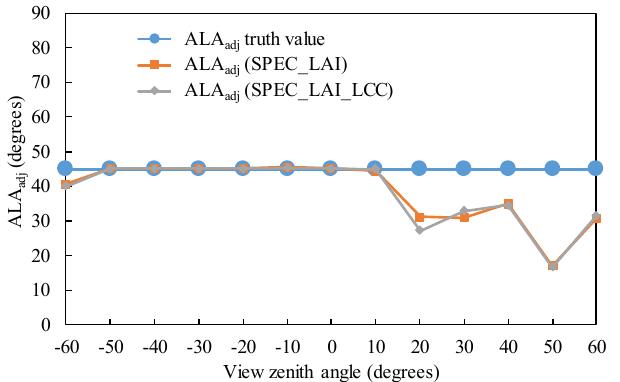
Figure 7. Applicability of the ALA adj parameterization model for nadir observation to different view zenith angles. The test scenario is a homogeneous canopy simulated by the PROSAIL model, with variations in the view zenith angle and a fixed ALA of 45 degrees. Here, the fixed ALA is equal to the ALA adj truth value.